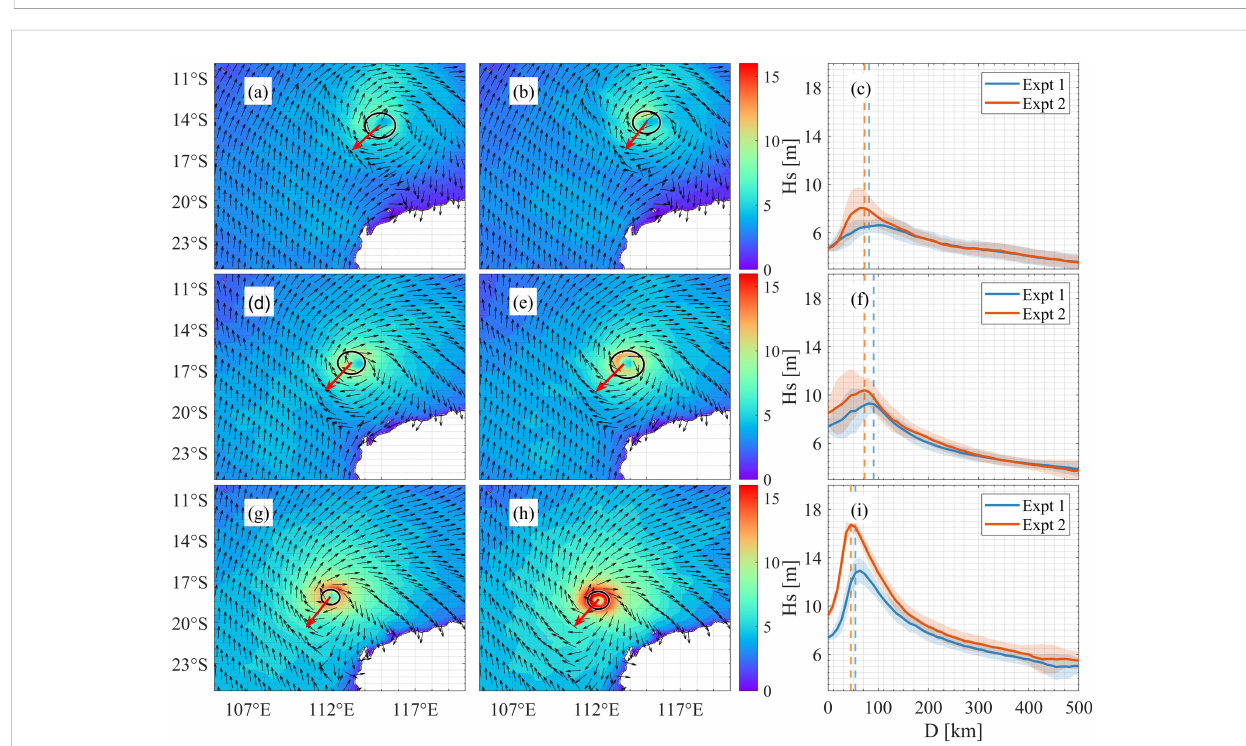
FIGURE 7 (A, D, G) are signi fi cant wave height (Hs) without the spume scheme on 10 – 12 January 2013. (B, E, H) are the same as (A, D, G) but with the spume scheme. (C, F, I) represent the azimuthal averages of Hs. The direction in which TC Narelle is moving forward at different times is demonstrated by the red arrows. The vectors are the propagation directions of the local waves. The azimuthal averages of Hs are shown by solid lines. The standard deviations of Hs in all radial directions are represented by shadows. The radius of maximum wind is represented by solid circles and dashed lines in spatial distributions and azimuthal averages,